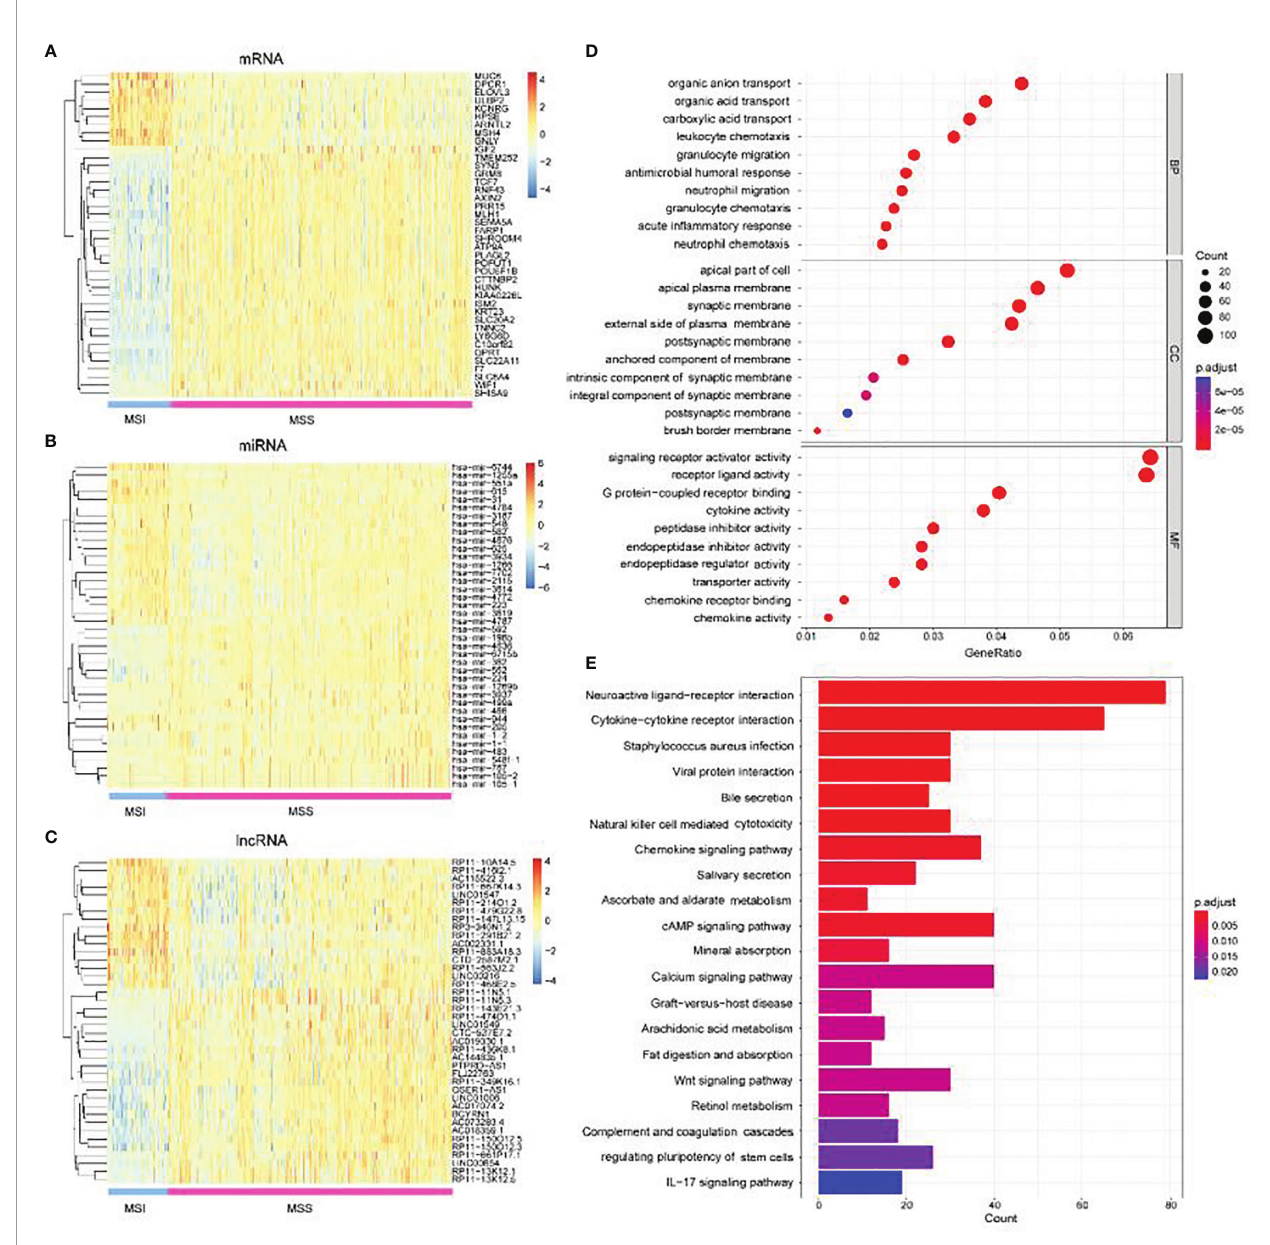
FIGURE 3 | Differential analysis of mRNA, miRNA, and lncRNA. (A) Heat map of the top 40 differentially expressed genes of mRNA. (B) Heat map of the top 40 differentially expressed genes of miRNA and (C) lncRNA. (D) GO analysis, including BP, CC, and MF. (E) KEGG enrichment